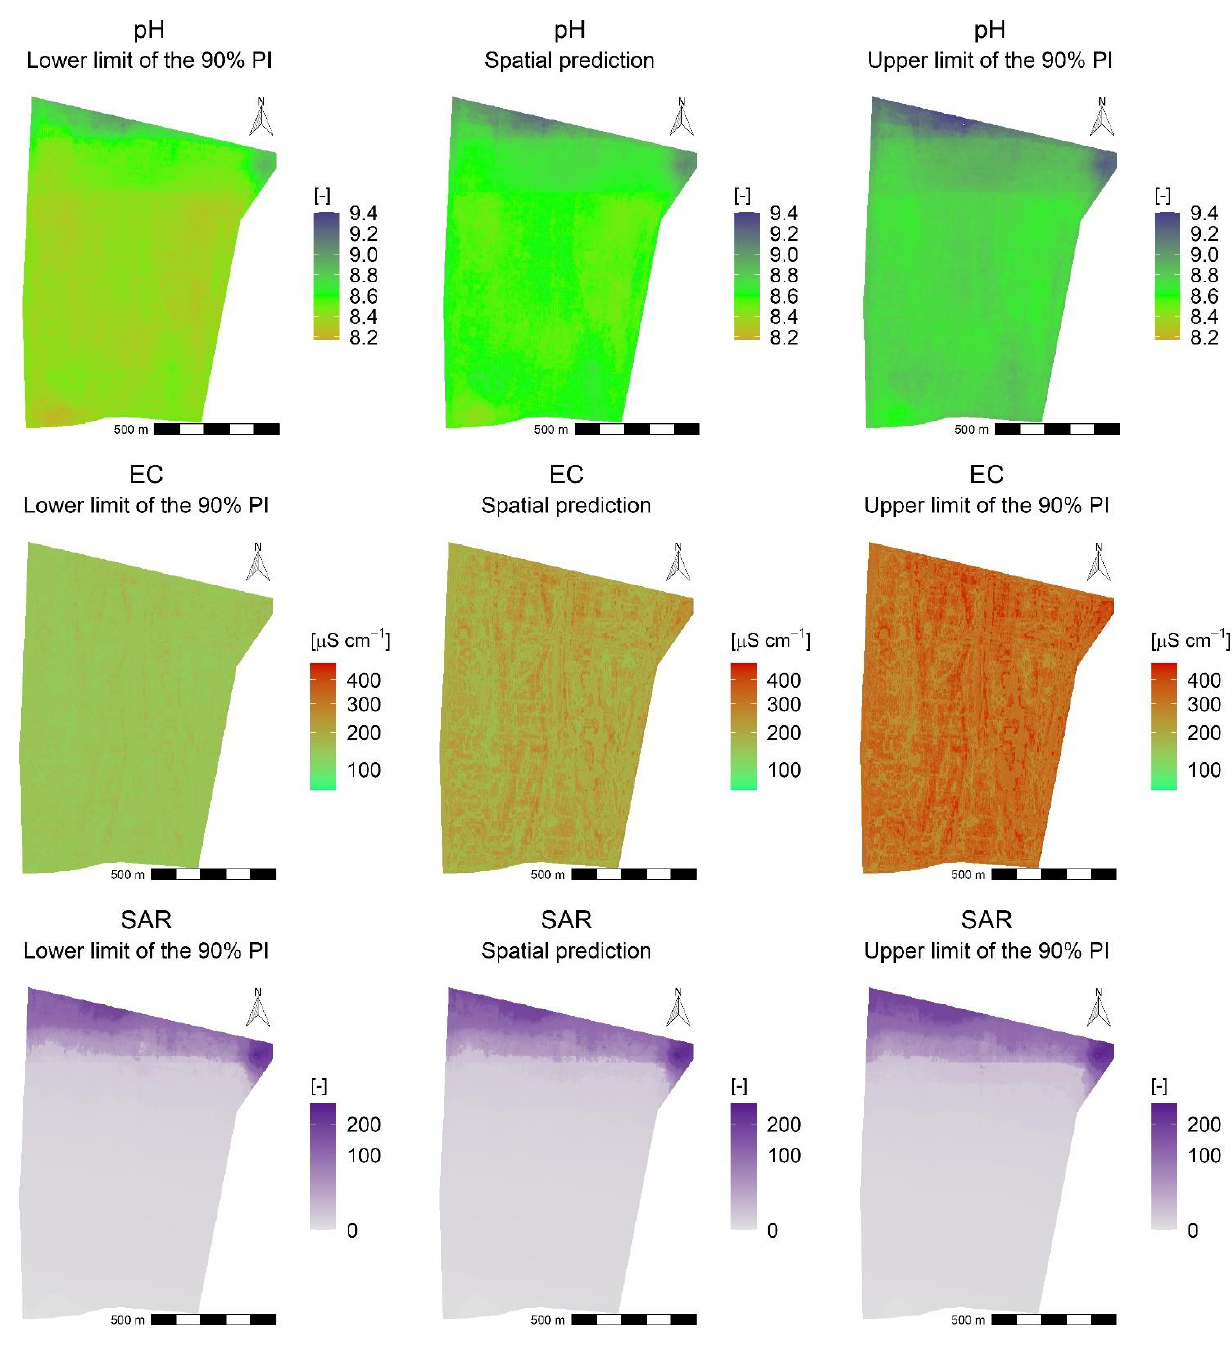
Figure 2. Spatial predictions ( middle column ) with the associated prediction uncertainty expressed by the 90% prediction interval ( left and right column ) for the indicators of salt-affected soils. Legend: Abbreviations: EC: electrical conductivity, SAR: sodium adsorption ratio, and PI: prediction interval. Table 2. Summary statistics of the indicators of salt-affected soils computed from the point obser- vations ( n = 85).